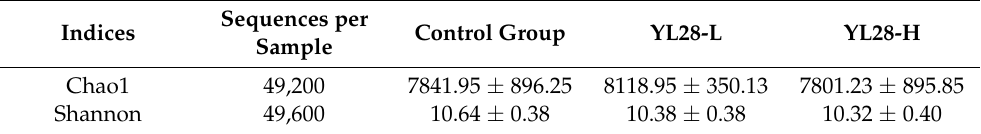
Figure 2. The indices of Chao1 and Shannon of bacterial community in sediment samples. ( a ) Number of reads to Chao1 index curve; ( b ) number of reads to Shannon index curve. Significant difference: p < 0.05; ( c ) Principal components analysis (PCA) of microbial communities. Colors and numbers were used to distinguish different systems and samples. Black: 1, CK-0. red: 2, CK-5; 3, CK-15; 4, CK-30. blue: 5, YL28-L5; 6, YL28-L15; 7, YL28-L30. Green: 8, YL28-H5; 9, YL28-H15; 10, YL28-H30. Significant difference: p < 0.05. Table 1. Richness and diversity indices estimation.